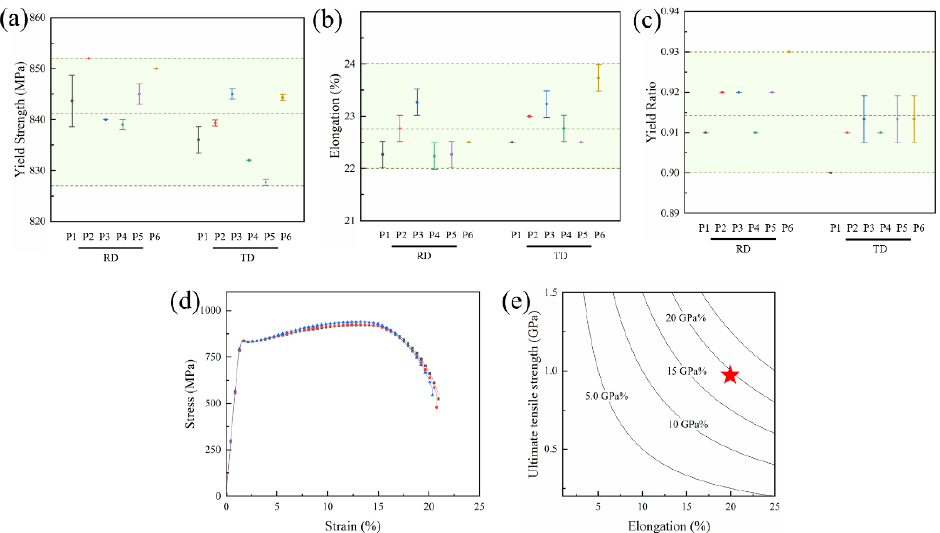
Figure 2. ( a – c ) Distributions of yield strength, elongation, and yield ratio of the specimens cutting from the plate at different positions, error bars represent mean value with the standard deviation; ( d ) stress–strain curves for specimen at position P4 along the TD; and ( e ) strength–ductility balance of the HSAL steel, the red star represents the PSE for current work.